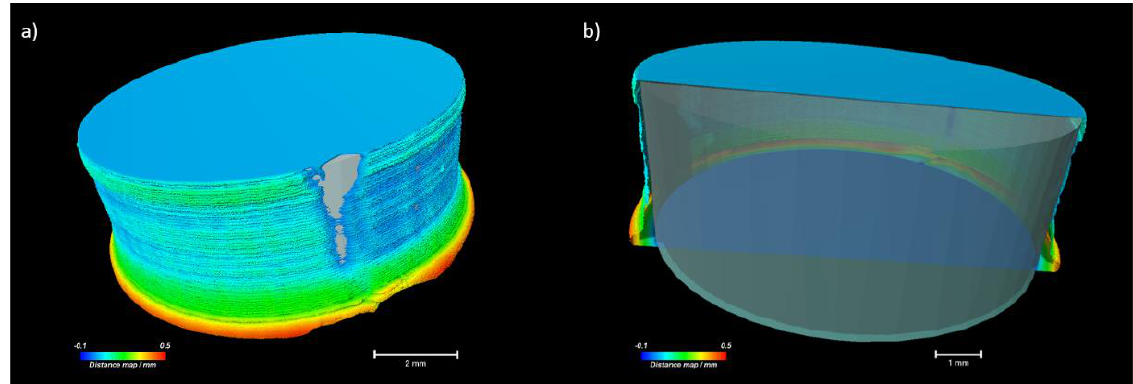
Figure 4. Comparison of the CAD model with the printed outer surface of the 3D-printed tablets containing 20% NAP. ( a ) Distance map comparing the surfaces of the CAD model and the 3D-printed tablet (colours show the displacement between the CAD model and the printed tablet; grey shows the CAD model). ( b ) Distance map (cropped halfway) and CAD model surface in lower opacity (grey).